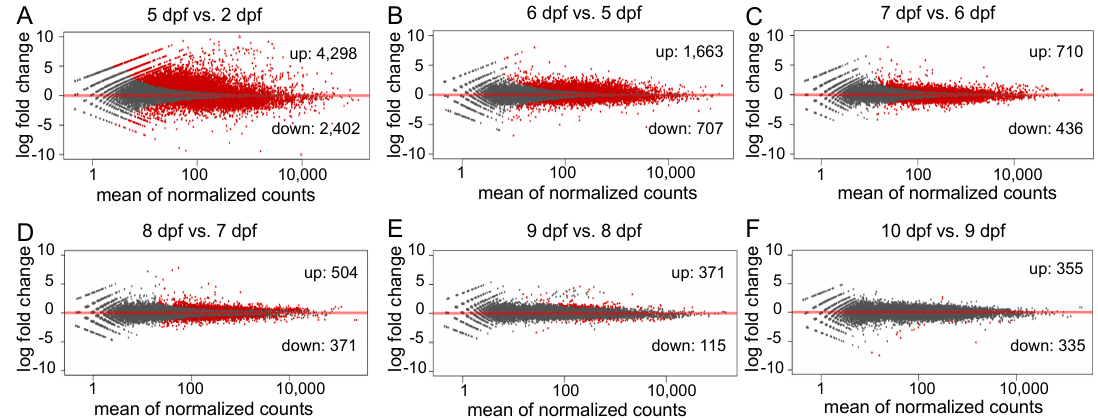
Figure 3. M-A plots (M: log ratio of expression fold change; A: mean of normalized counts) of the differentially expressed genes (DEGs) in different comparisons during early development in channel catfish, Ictalurus punctatus . Red dots indicate the downregulation (negative value) or upregulation (positive value). Black dots represent non-DEGs. ( A ) 5 days post fertilization (dpf) vs. 2 dpf, ( B ) 6 vs. 5 dpf, ( C ) 7 vs. 6 dpf, ( D ) 8 vs. 7 dpf, ( E ) 9 vs. 8 dpf and ( F ) 10 vs. 9 dpf.